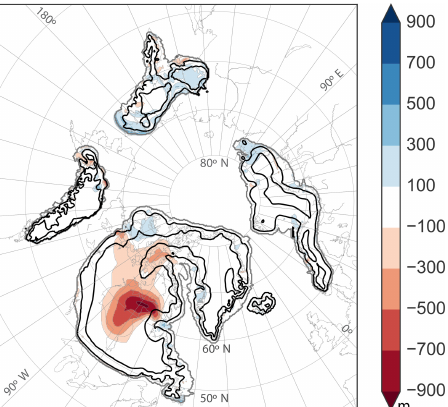
Figure 4. Ice surface elevation change in composite year 1250 compared with composite year − 50. Overlays mark ice sheet out- line (gray) and surface elevation (black) at 1000, 2000, and 3000m in the pre-surge phase. The Laurentide Ice Sheet barely misses 3000m. The peak of Greenland slightly exceeds this elevation. Stereographic projection around 71 ◦ N, 44 ◦ W with grid lines at multiples of 10 ◦